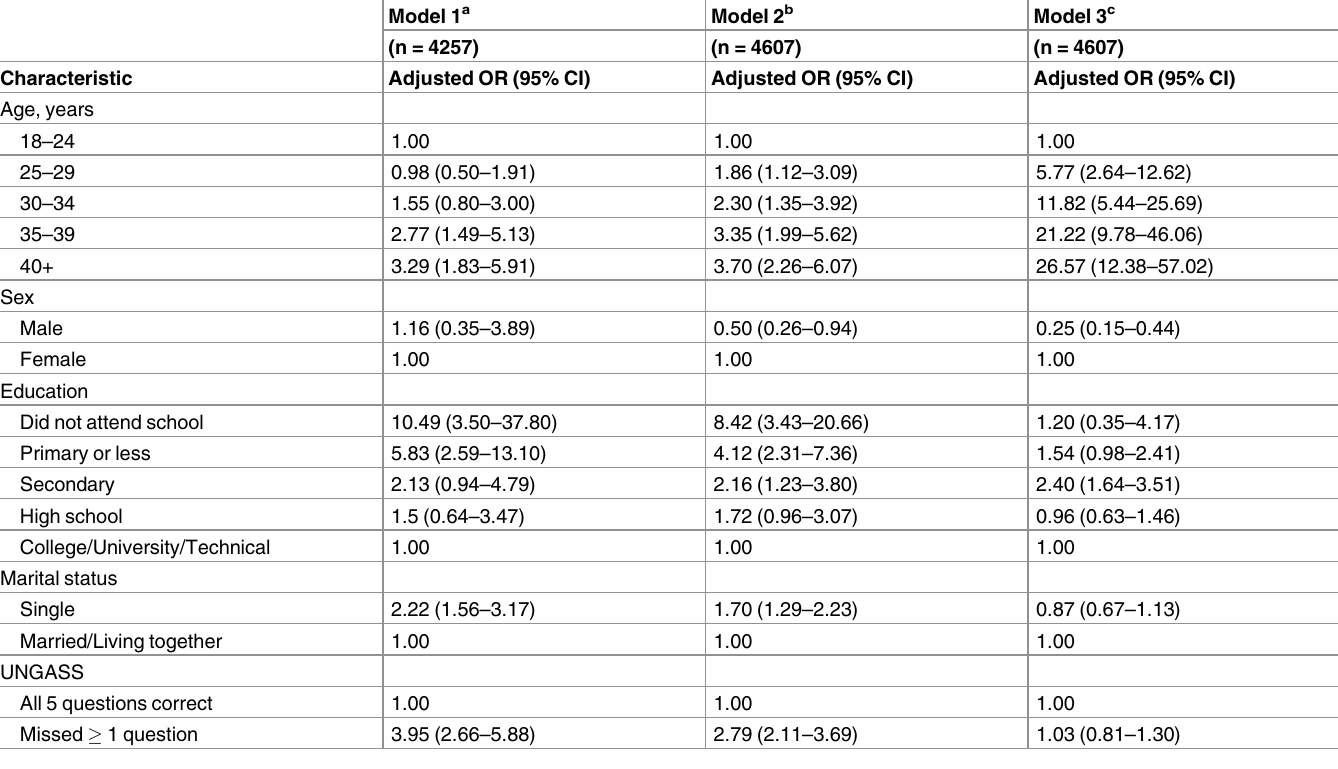
Table 2. Adjusted odds of demographic and knowledge factorsassociatedwith incorrectly self-reporting HIV positive status (Model 1), incorrectly self-reporting HIV status (Model 2), and testing HIV positive using the RDT algorithm (Model